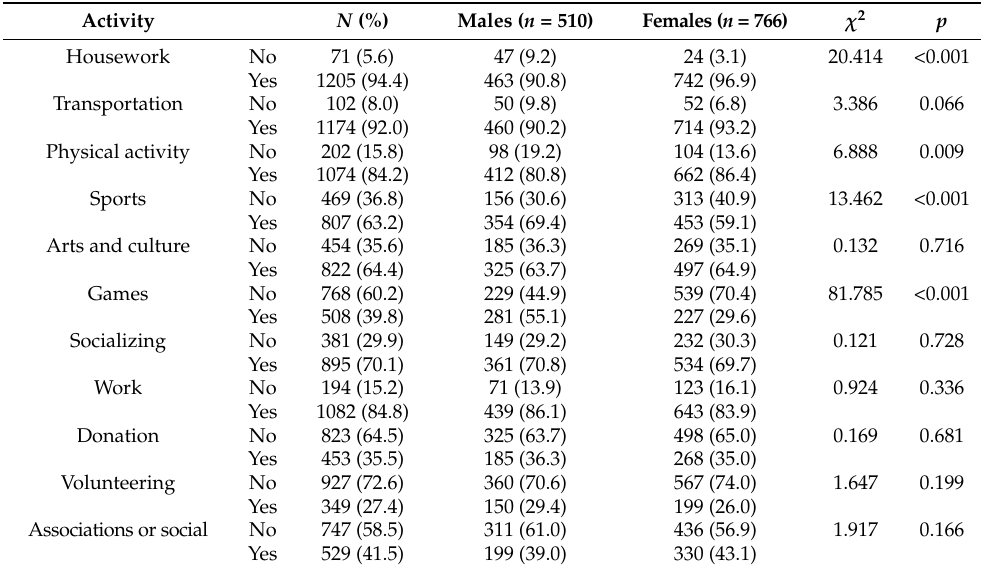
Table 3. Social participation data and differences based on sex ( n =